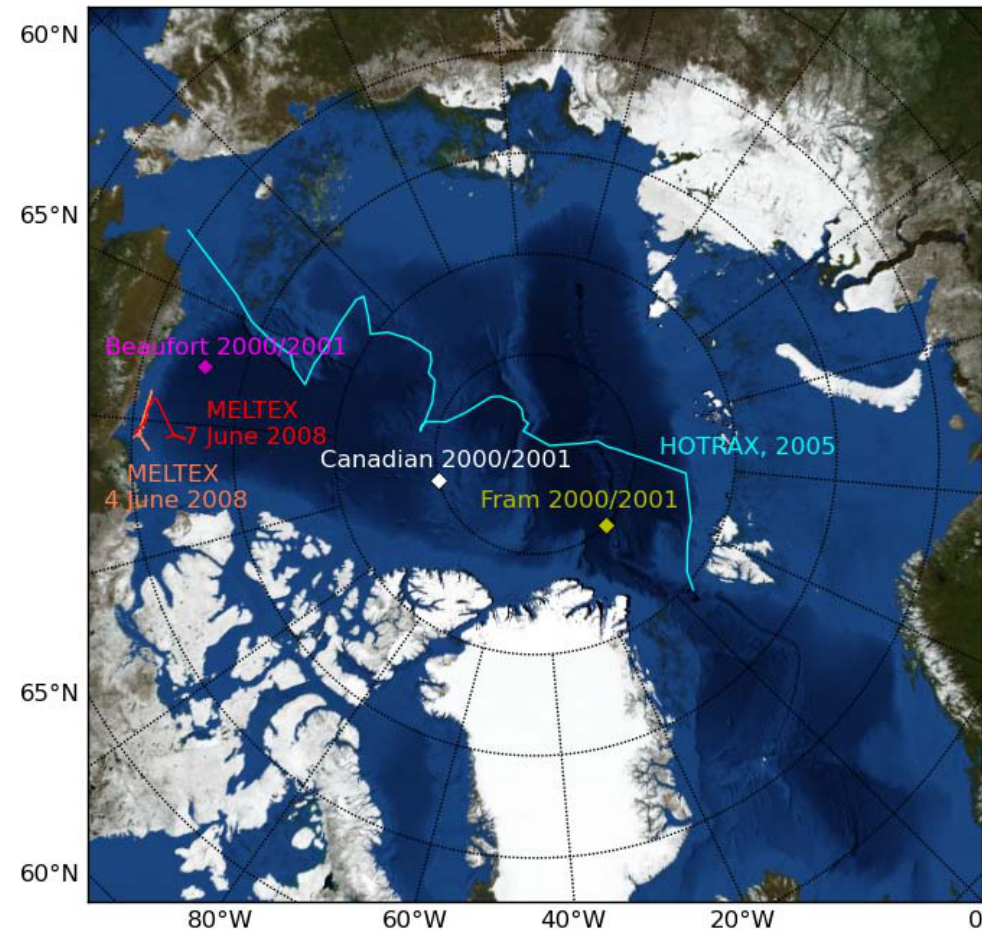
Fig. 1. Tracks, locations and dates of validation data sets. Detailed descriptions are given in the